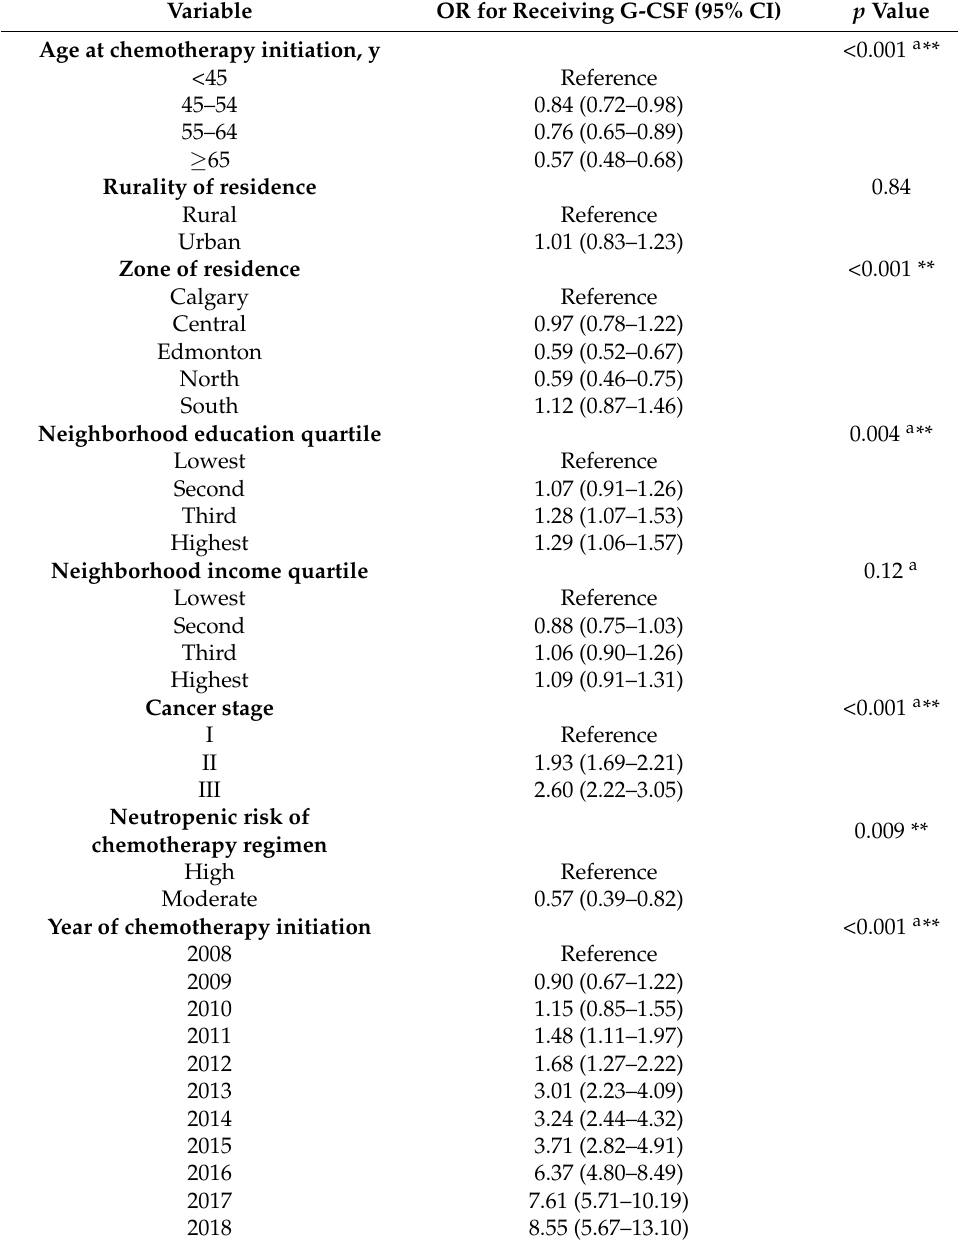
Table 3. Multivariable logistic regression analysis of predictors of G-CSF use.